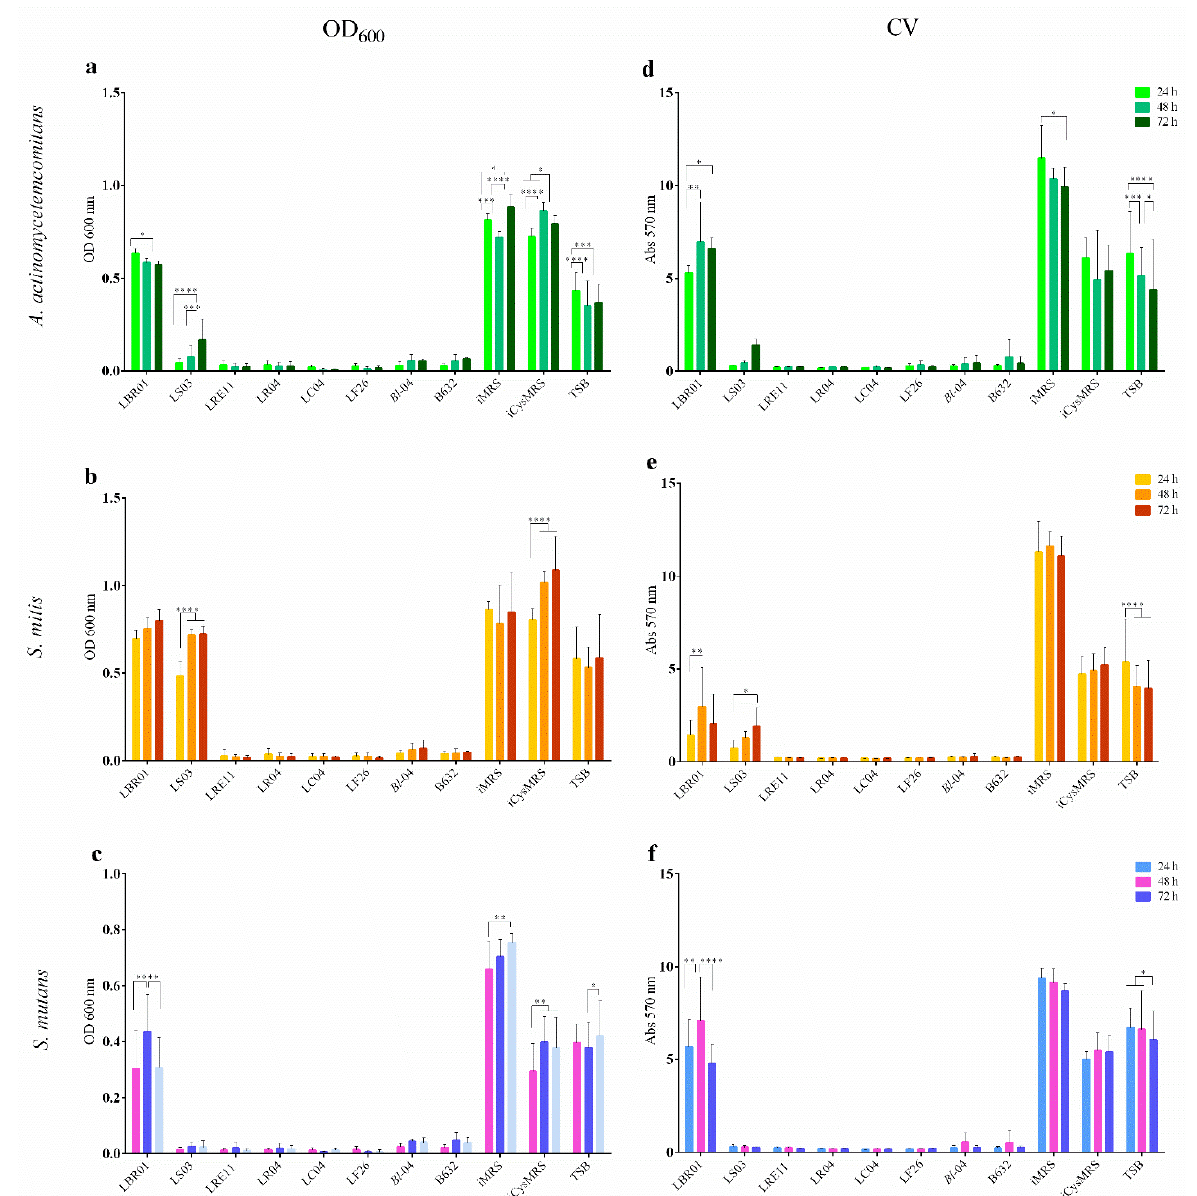
Figure 3. Optical density (OD) measurement at 600 nm and crystal violet (CV) biofilm quantification. CFSs were assayed to determine their ability in preventing pathogen biofilm formation through OD 600 measurements for ( a ) A. actinomycetemcomitans , ( b ) S. mitis , and ( c ) S. mutans ; and CV